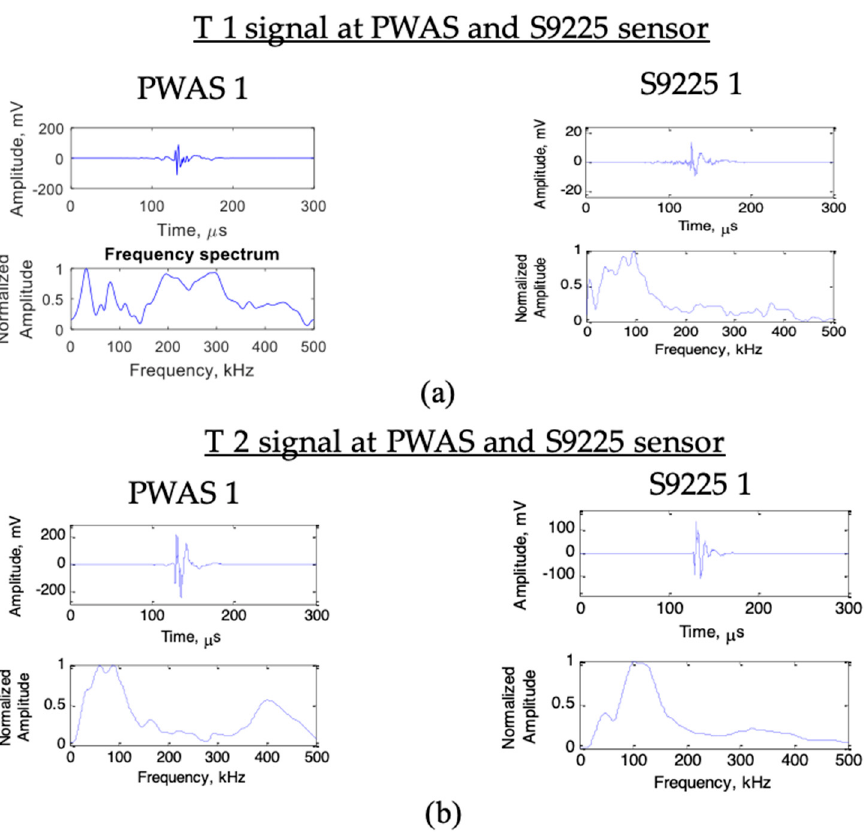
Figure 17. Comparison of T1 and T2 signature at PWAS and S9225 sensors. ( a ) T1 signature at PWAS − 1 and S9225 − 1. ( b ) T2 signature at PWAS and S9225.